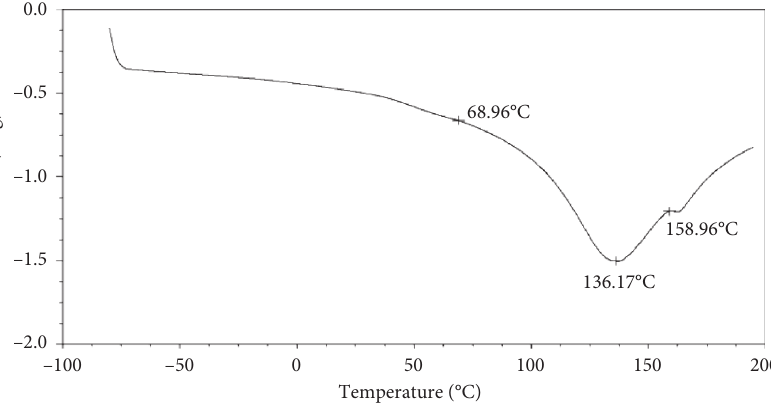
Figure 5: DSC for WM.